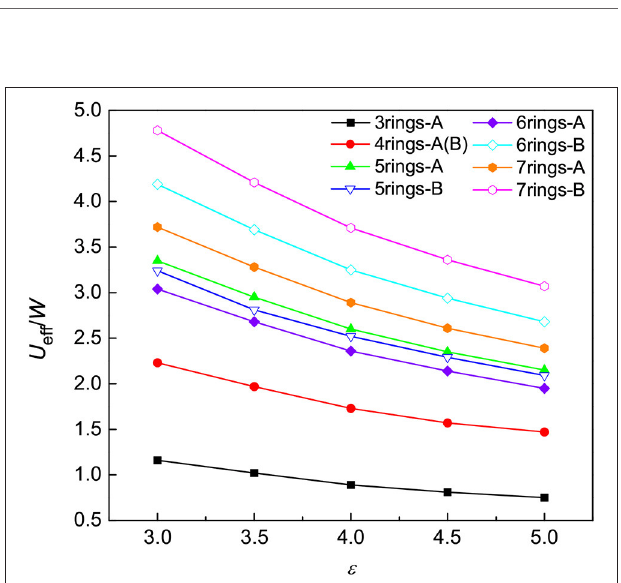
FIGURE 7 | The electron-electron correlations of aromatic hydrocarbons. The effective electronic correlation parameter U eff / W of two kinds of optimized structures is plotted as a function of the dielectric constant ε . The configuration with the zigzag arrangement of benzene rings is classified as A, such as phenanthrene and picene, while B denotes the configuration with the arrangement of benzene rings such as 1,2:8,9-dibenzpentacene and